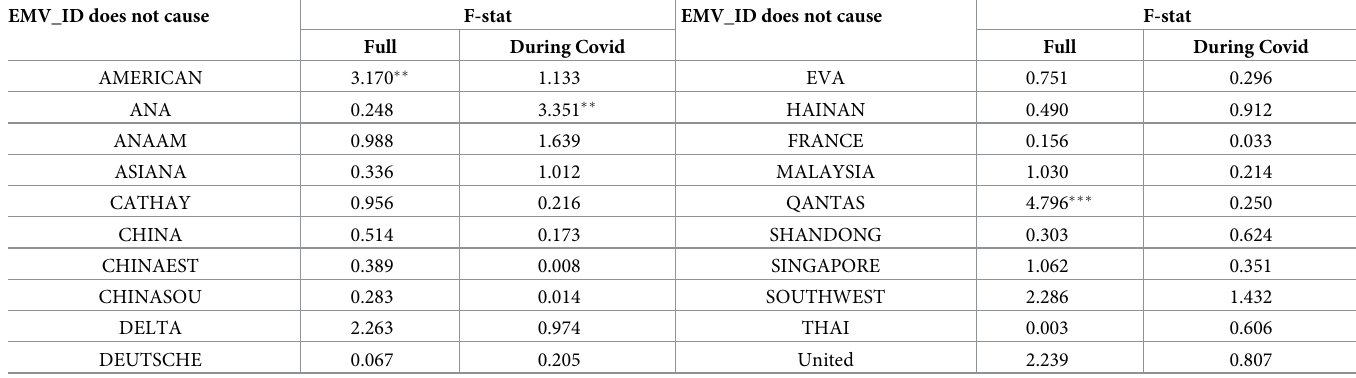
Table 2. Linear causality of [27].